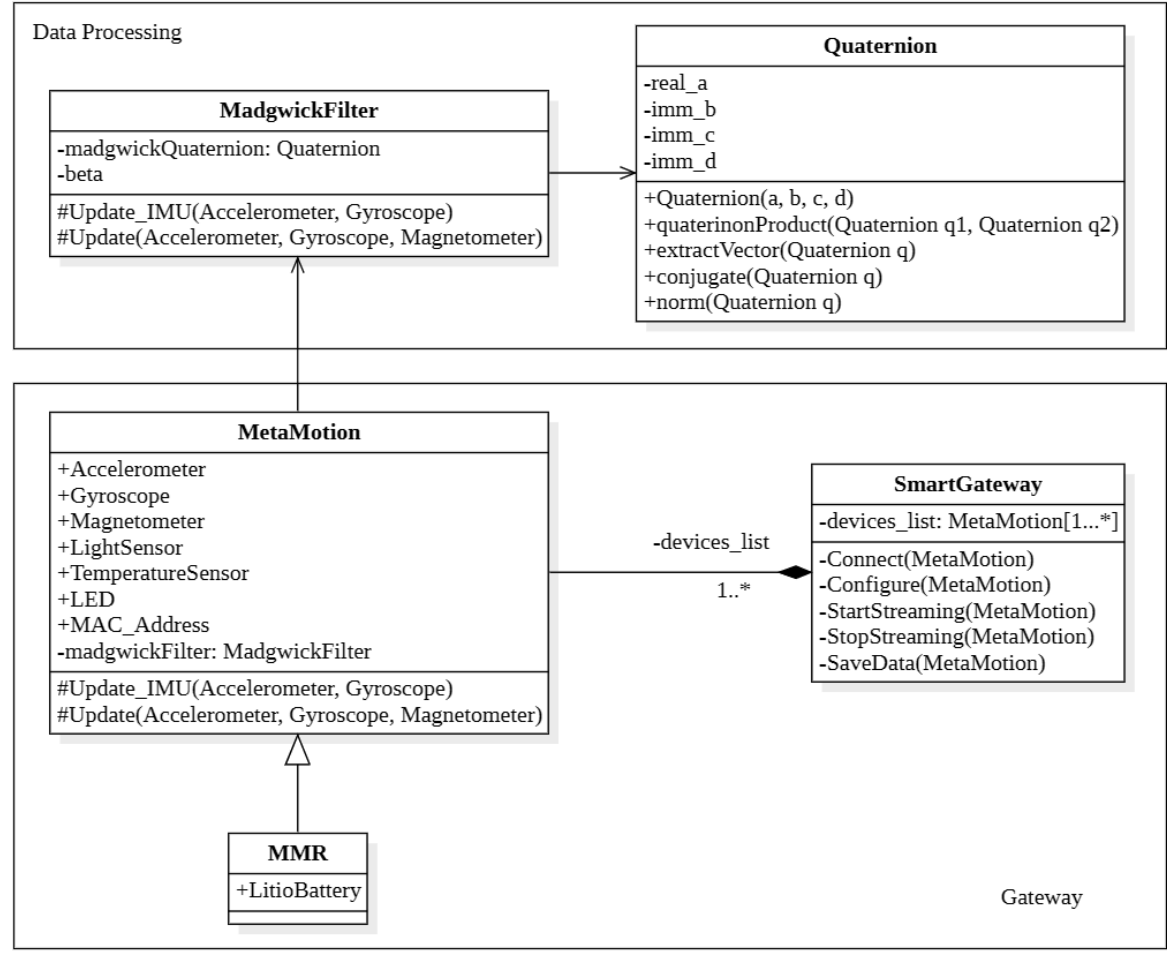
Figure A2. UML Class Diagram of the back-end software module of IMU sensors network system used in this work. The writing (1...*) stands for “from 1 to